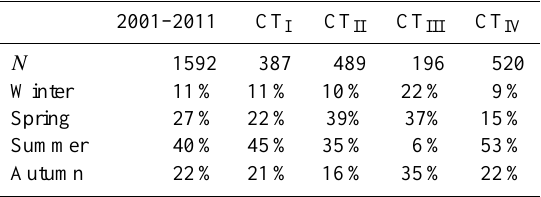
Table 3. Occurrence of episodic days during the period 2001–2011 and during each circulation type (CT i ) .